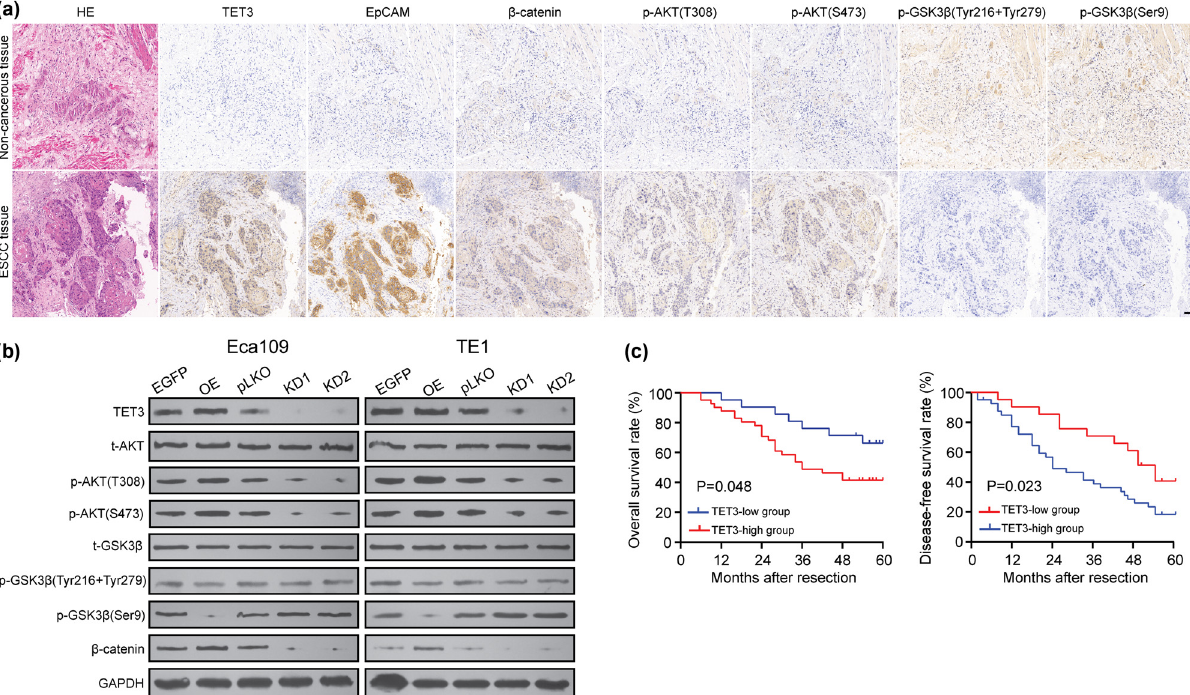
Figure 5: TET3 increased the viability, motility, and stem cell characteristics of ESCC cells by regulating the PI3K/AKT/GSK3 β / β - catenin axis. ( a ) Representative fi elds of signaling pathway - related protein expression, including TET3, EpCAM, β - catenin, p - AKT ( T308 and S473 ) , and p - GSK3 β ( Tyr216/279 and Ser9 ) , in ESCC samples ( scale bar = 50 μ m ) . ( b ) Western blot assay was used to detect the expression of signaling pathway - related protein in ESCC cells. ( c ) OS and DFS analyses of TET3 in patients with ESCC ( n = 62 ) .